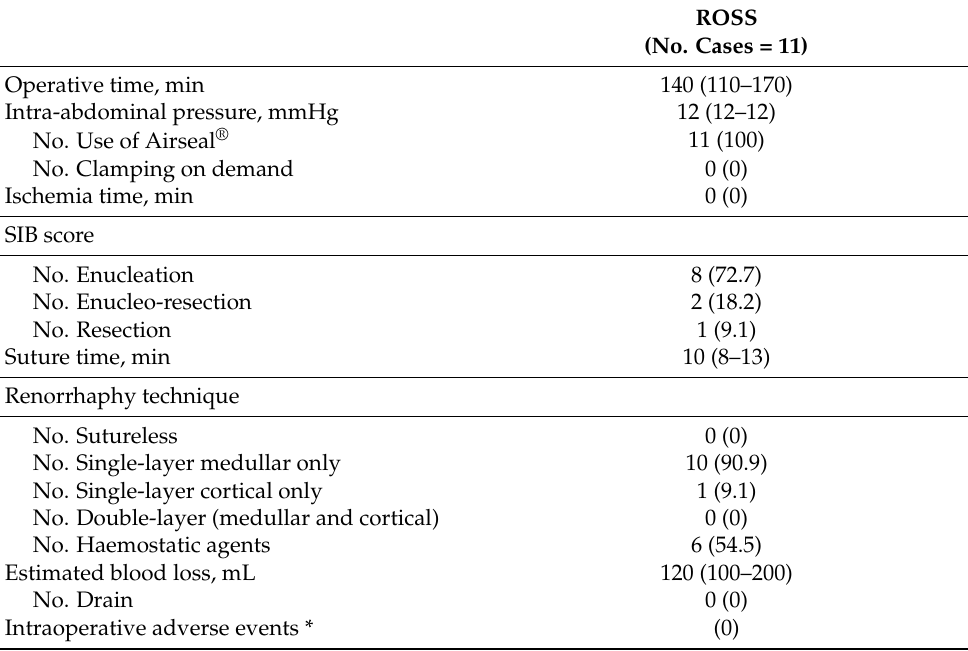
Table 2. Distribution of intraoperative outcomes.